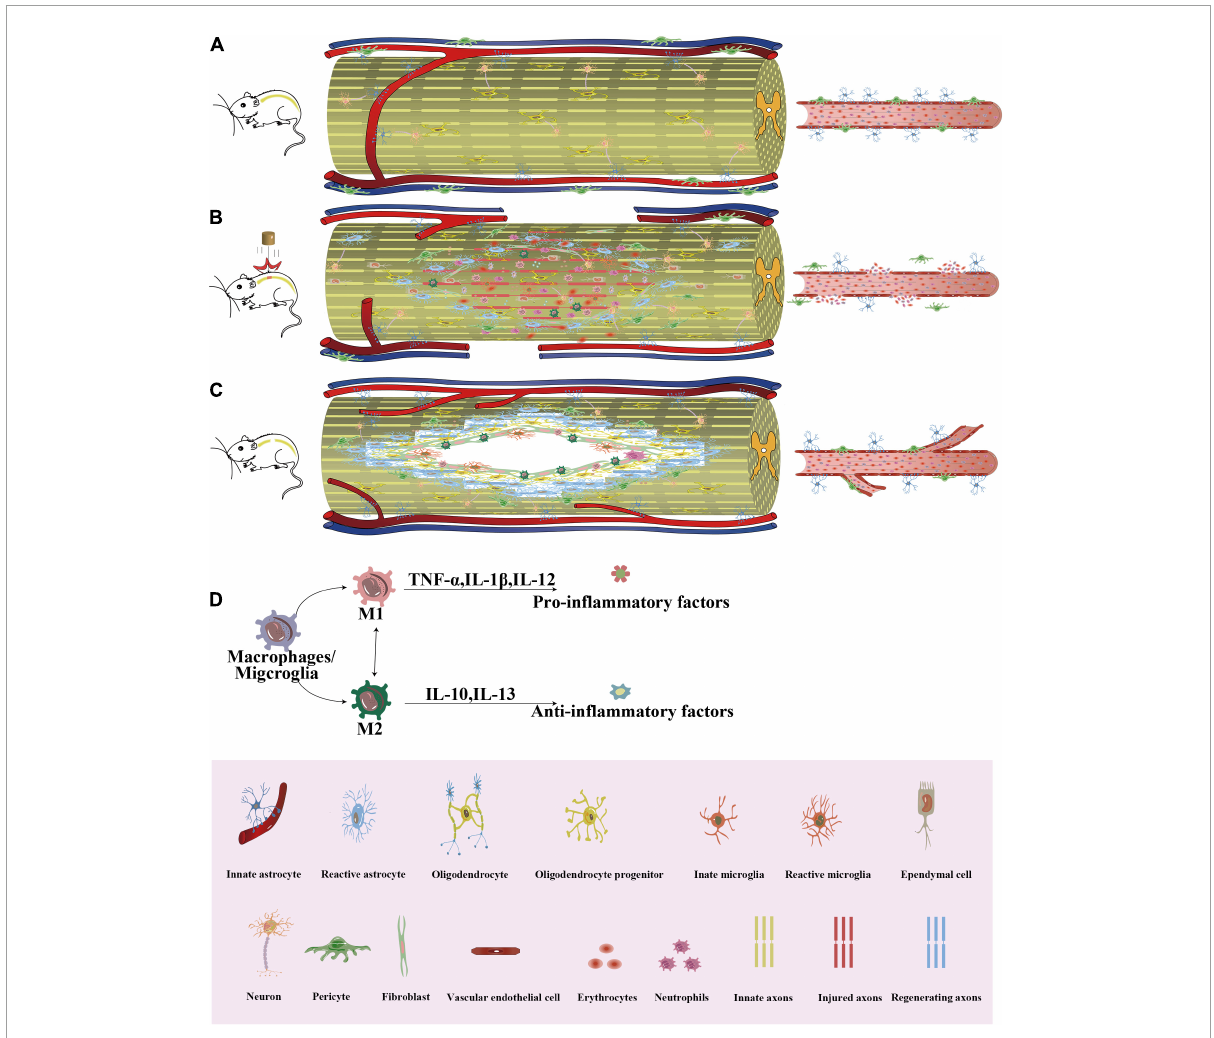
FIGURE1 The process of cellular repair of SCI. After SCI, a series of repeated cascade responses, including cellular as well as non-cellular reactions, will occur. (A) Normal spinal cord and paraspinal vessels in uninjured mice. (B) In the acute phase of SCI, the BSCB is disrupted, neuronal death occurs, Wallerian degeneration of distal axons with a demyelinating response, permeability of the vessel wall increases, hematomas form, and hematogenous macrophages and neutrophils are recruited to the core of the lesion. Astrocytes migrate toward the core of the lesion and envelop the damaged tissue, thus protecting the remaining tissue from further damage. Microglia are also activated and morphologically altered to engulf the necrotic tissue along with blood-derived macrophages. Oligodendrocyte precursor cells have a marked ability to proliferate and interact with reactive glial cells at the border of the injury. Fibroblasts induced a marked fibroblast response, with large numbers of fibroblasts depositing around the core of the lesion. Epithelial cells migrated from the central canal of the spinal cord to the site of injury and participated in repair as endogenous stem cells. Pericytes detach from the basement membrane of the vessel wall and migrate to the injury site to participate in glial scar formation and to close the center of the injury. (C) In the chronic phase of SCI, the core of the lesion is often not effectively treated, resulting in the formation of a cavity in the lesion area surrounded by a glial scar formed by aggregates of hypertrophic astrocytes, pericytes, fibroblasts, and NG2+ oligodendrocytes, with neovascularization and accompanied by a small amount of myelin and axon formation. (D) The inflammatory environment causes changes in the macrophage phenotype. SCI, Spinal cord injury; BSCB, Blood-spinal cord barrier; TNF, Tumor necrosis factor; IL, Interleukin; NG2, Neuron-glial antigen